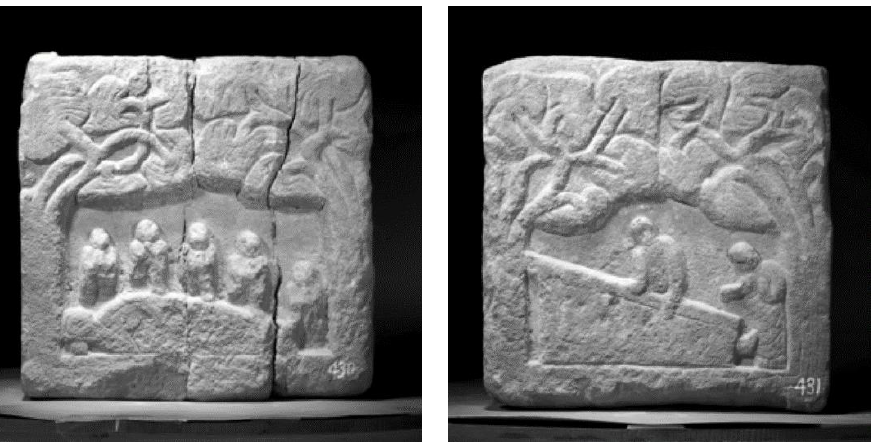
Figure 11. Nirvā ṇ a. Scenes no. 430 and no. 431. Stone block, Nannieshui, Shanxi province. Mid-sixth century. Nannieshui Museum. Source: (Cao 2011, Figures 6 and 7).